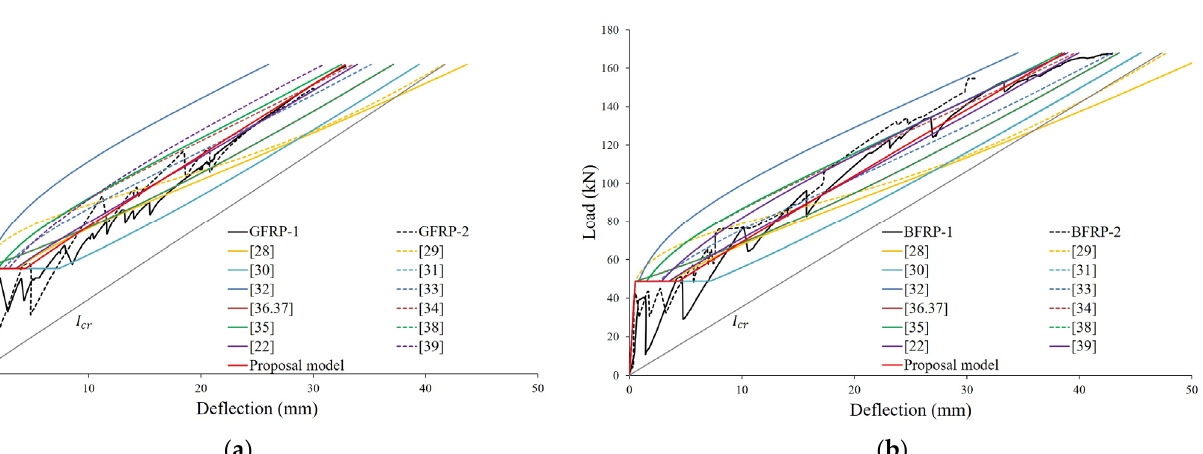
( b ) Figure 7. Experimental versus predicted midspan deflection of GFRP Specimens: ( a ) Ratio of exper- imental and predicted deflection at service load; ( b ) Ratio of experimental and predicted deflection at ultimate load.